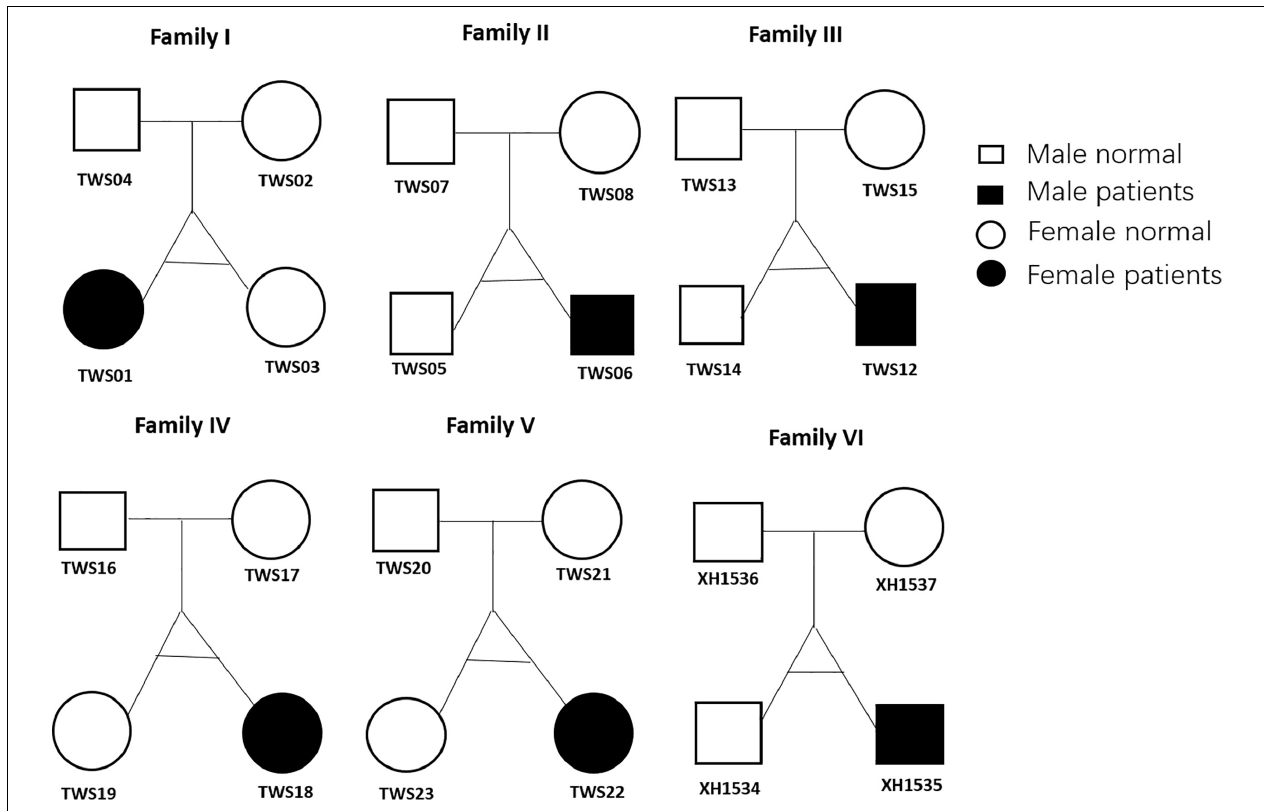
FIGURE 1 | Twin family pedigrees. Symbols indicate a female (circle) or male (square) family member; The text next to the symbols represents the family member ID. Whole-exome sequencing was performed for all 24